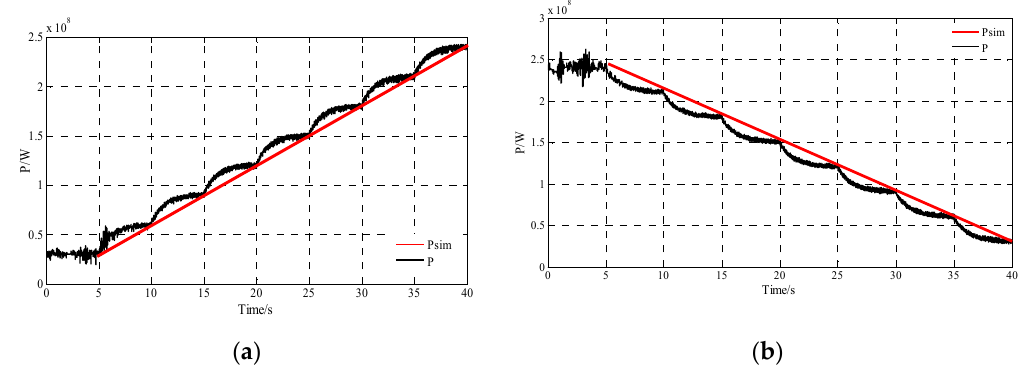
Figure 20. Comparison of active power waveform before and after equivalent. ( a ) load ramping stage; ( b ) load rejection stage.